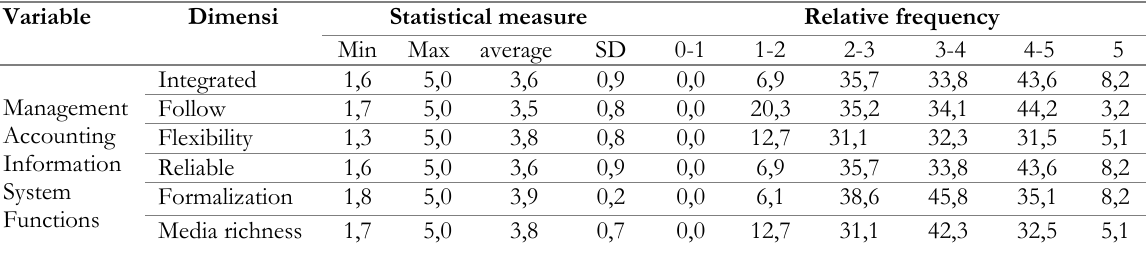
Descriptive Statistics Variable Functions of Management Accounting Information